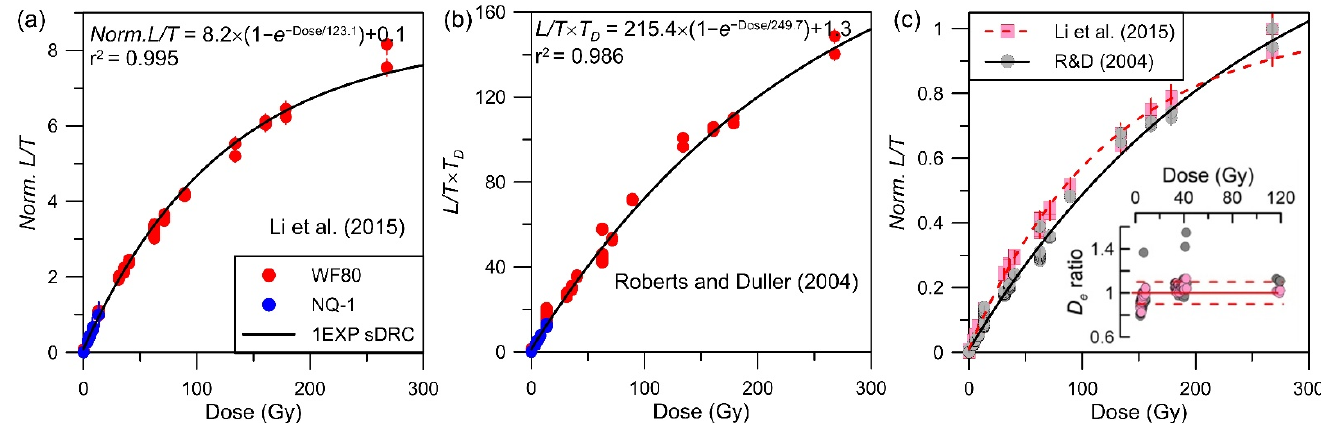
Figure 5. sDRC construction for FG samples from cores WF80 and NQ-1 using the method of [28] ( a ) and [30] ( b ). ( c ) shows the comparison of the two sDRCs. Inset shows the sDRC- D e over individual DRC- D e